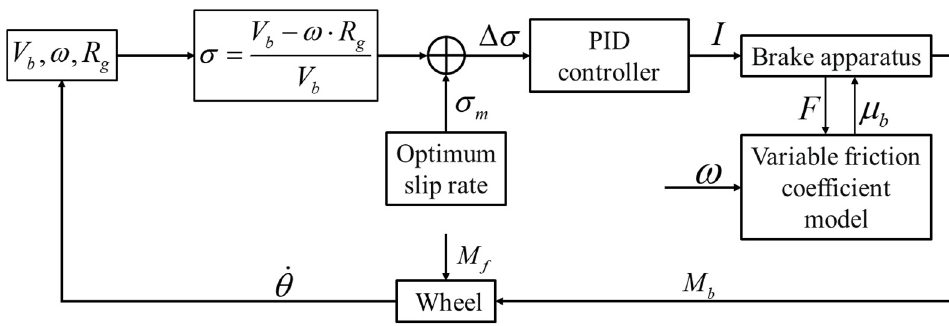
Figure 5. Brake control principle.